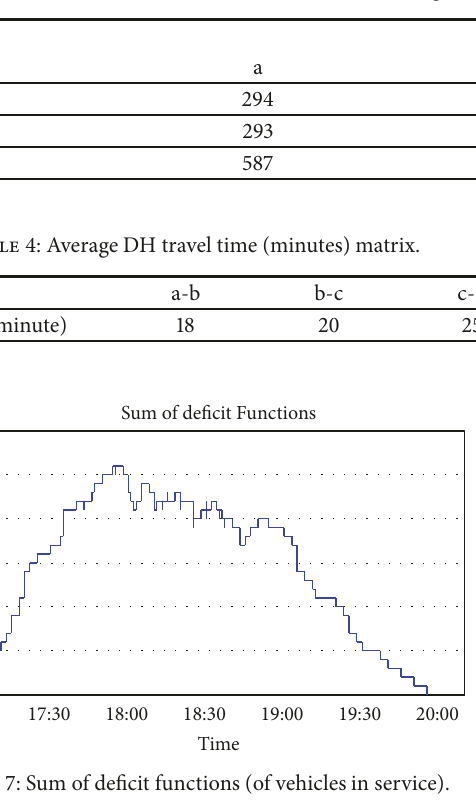
the departure time. The time for the 39th trip to the right is 14min, and the range for the left/right adjustment for other adjustments is 8min, i.e., Δ = ±8 min. The number of the vehicles for adjusting the departure time is shown in Table 5 and the time to insert a DH trip is shown in Table 6.